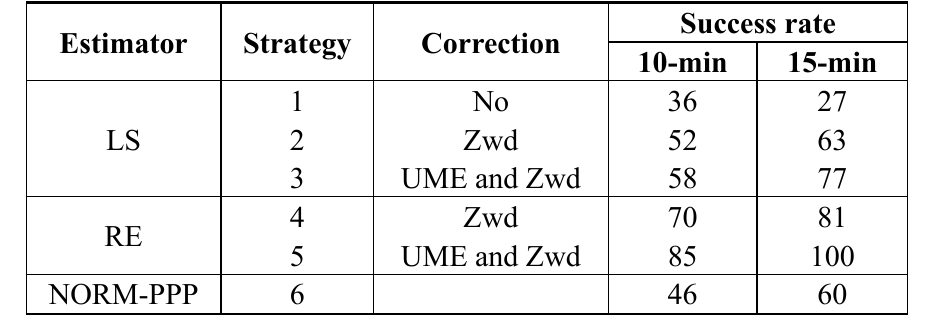
Table 1. Strategies, Success rate (in %) within 10-min and 15-min time window.